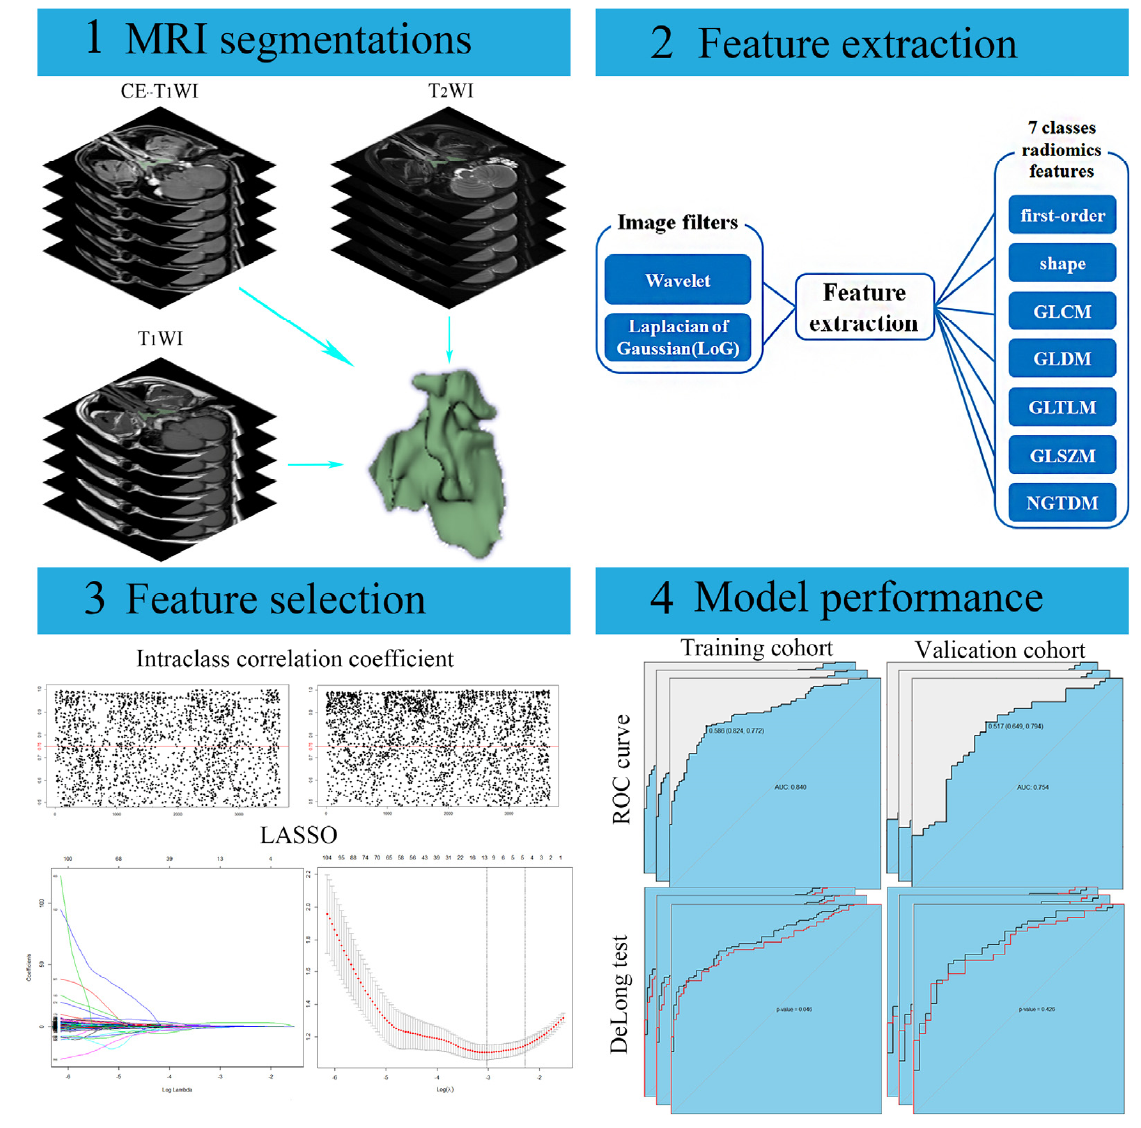
Figure 2. The workflow of model construction and evaluation. Note: MRI, Magnetic resonance image. CE-T1WI, Contrast-enhanced T1-weighted image. T1WI, T1-weighted image. T2WI, T2-weighted image. GLCM, Gray-level co-occurrence matrix. GLDM, Gray-level dependence matrix. GLRLM, Gray-level run length matrix. GLSZM, Gray-level size zone matrix. LoG, Laplacian of Gaussian. NGTDM, Neighboring gray tone difference matrix. LASSO, Least absolute shrinkage and selection operator. ROC, Receiver operator characteristic.